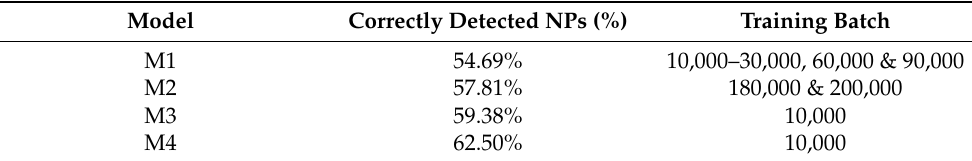
Table 7. Detection results for all models on the validation Dataset